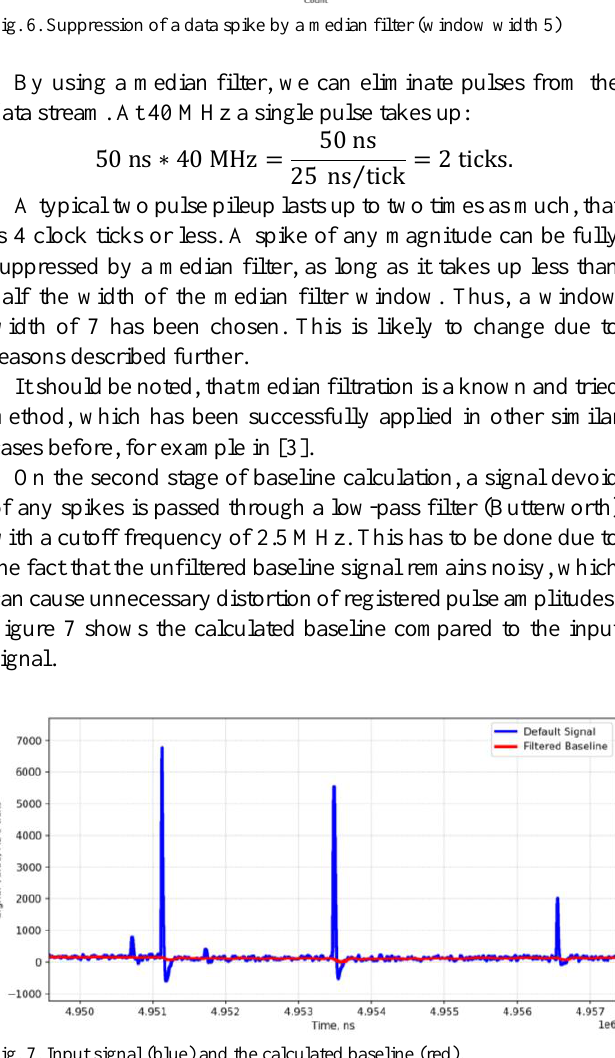
Fig. 6. Suppression of a data spike by a median filter (window width 5)